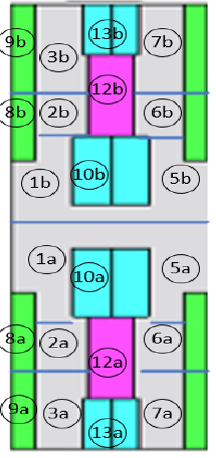
Figure 27. Machine division based on the nature of the